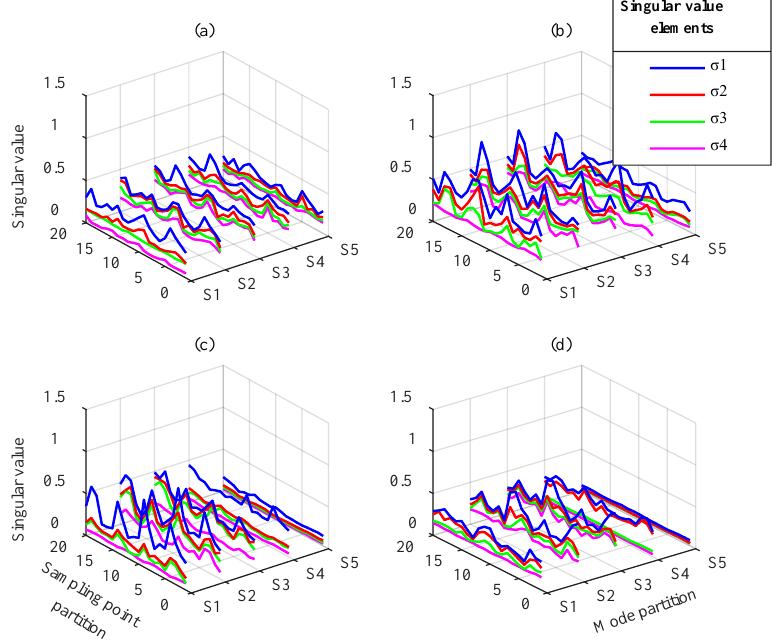
Figure 9. Singular value vector matrices from VMD: ( a ) normal gear, ( b ) gear with wear, ( c ) gear with breakage, and ( d ) gear with root crack tooth.